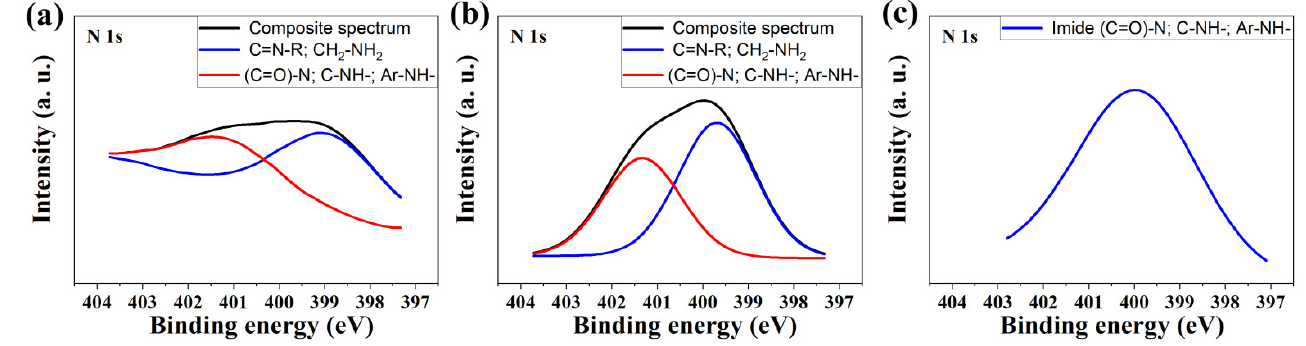
Figure 7. XPS spectra for N1s of representative samples of the obtained N-rich activated carbons: